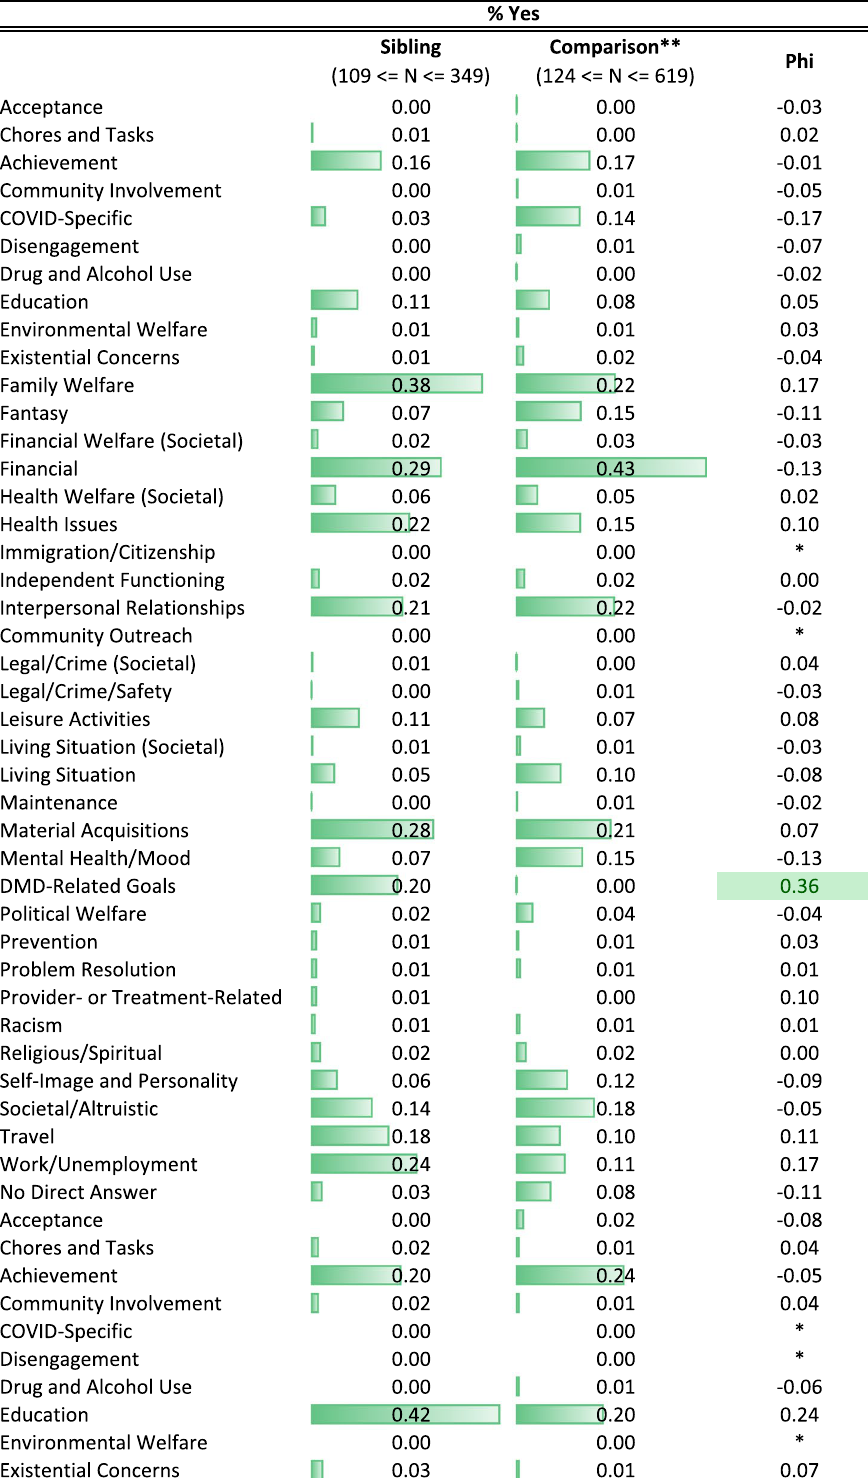
Table 2 Descriptive statistics for themes from open-text